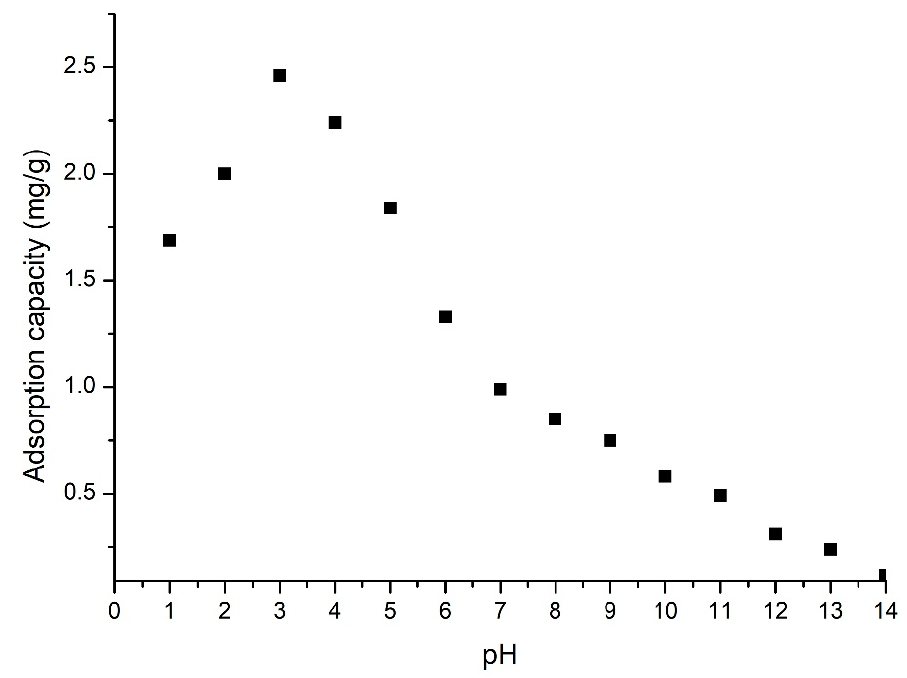
Figure 8. The pH in fl uence.